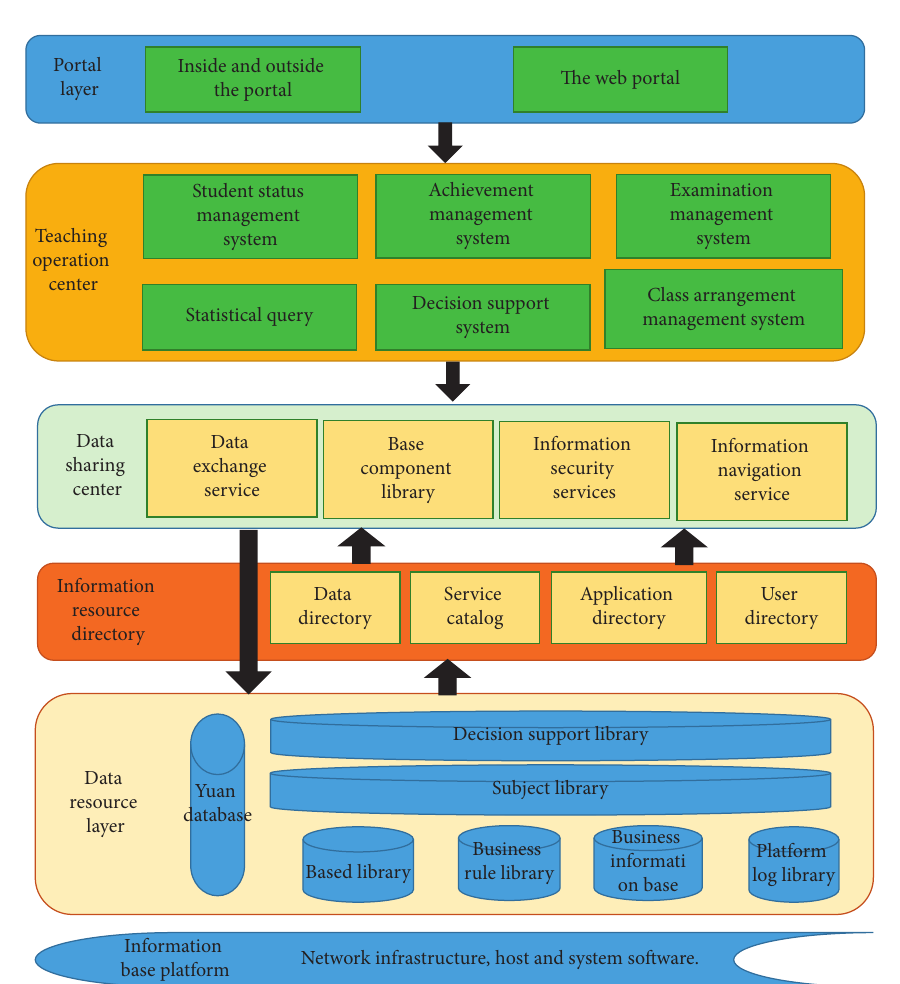
Figure 2: The system design of logic